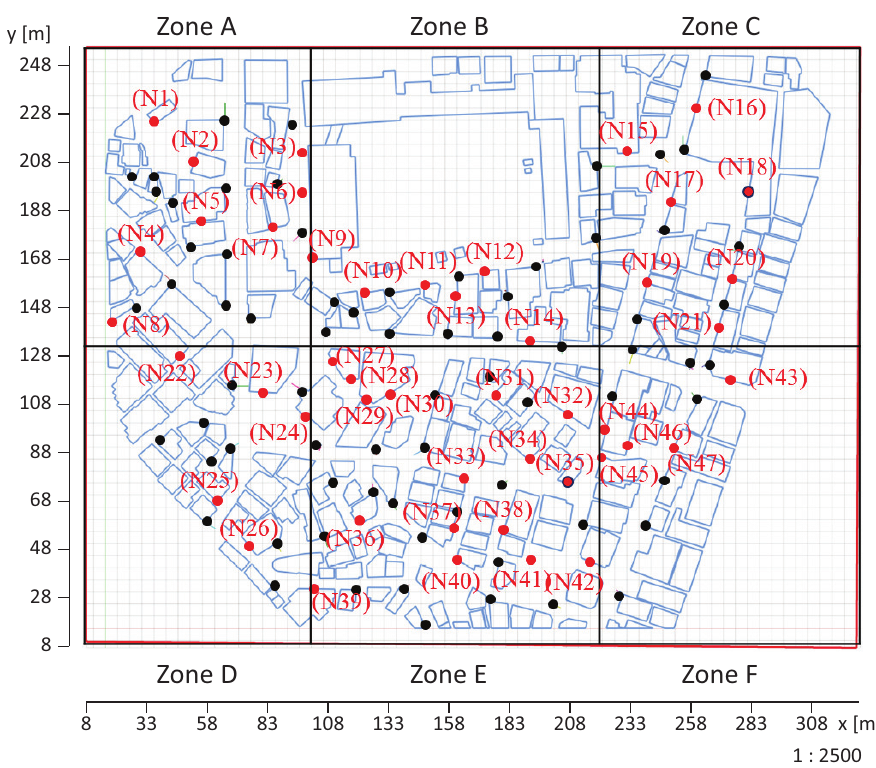
Figure 3. Alternative plan for improving the street lighting. Notes: Black points indicate current streetlights; red points indicate new streetlights with new locations; a red point with a black circle means improved street lighting in the current